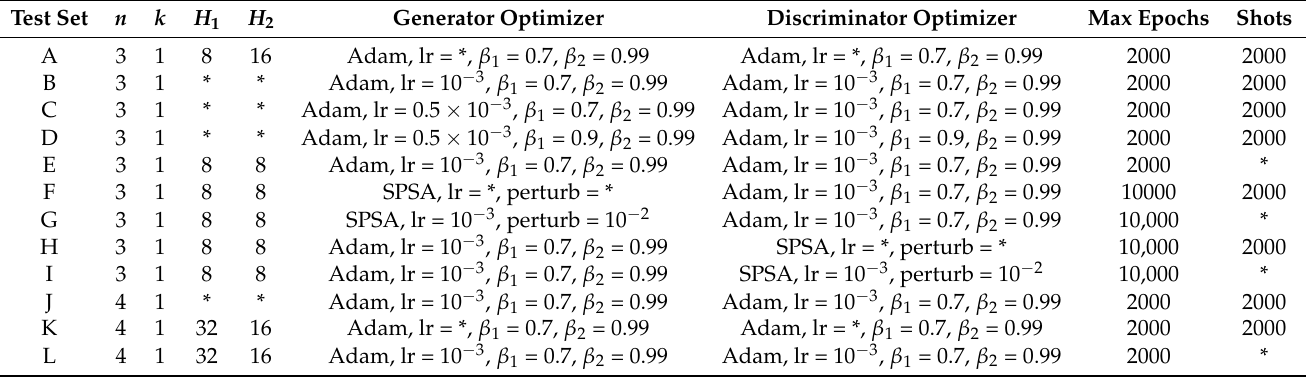
Table A1. The enumeration of the most relevant tests. Every test set provides a sensitivity analysis over some parameters, marked with a star (*) in the table.